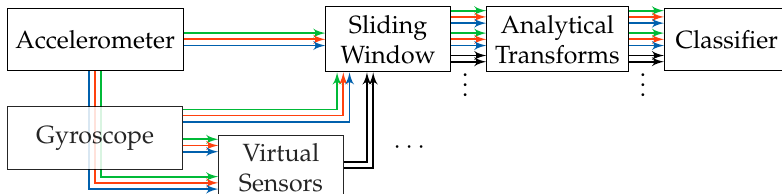
Figure 4. Flow diagram of the pattern recognition pipeline employed for the approach based on analytical transformations. Accelerometer and gyroscope each output the three streams x-axis (green), y-axis (blue), z-axis (red), which are processed independently throughout the pipeline until their features are concatenated for classification. Virtual sensors supply additional, artificially created, sensor channels (black). No preprocessing is required for this